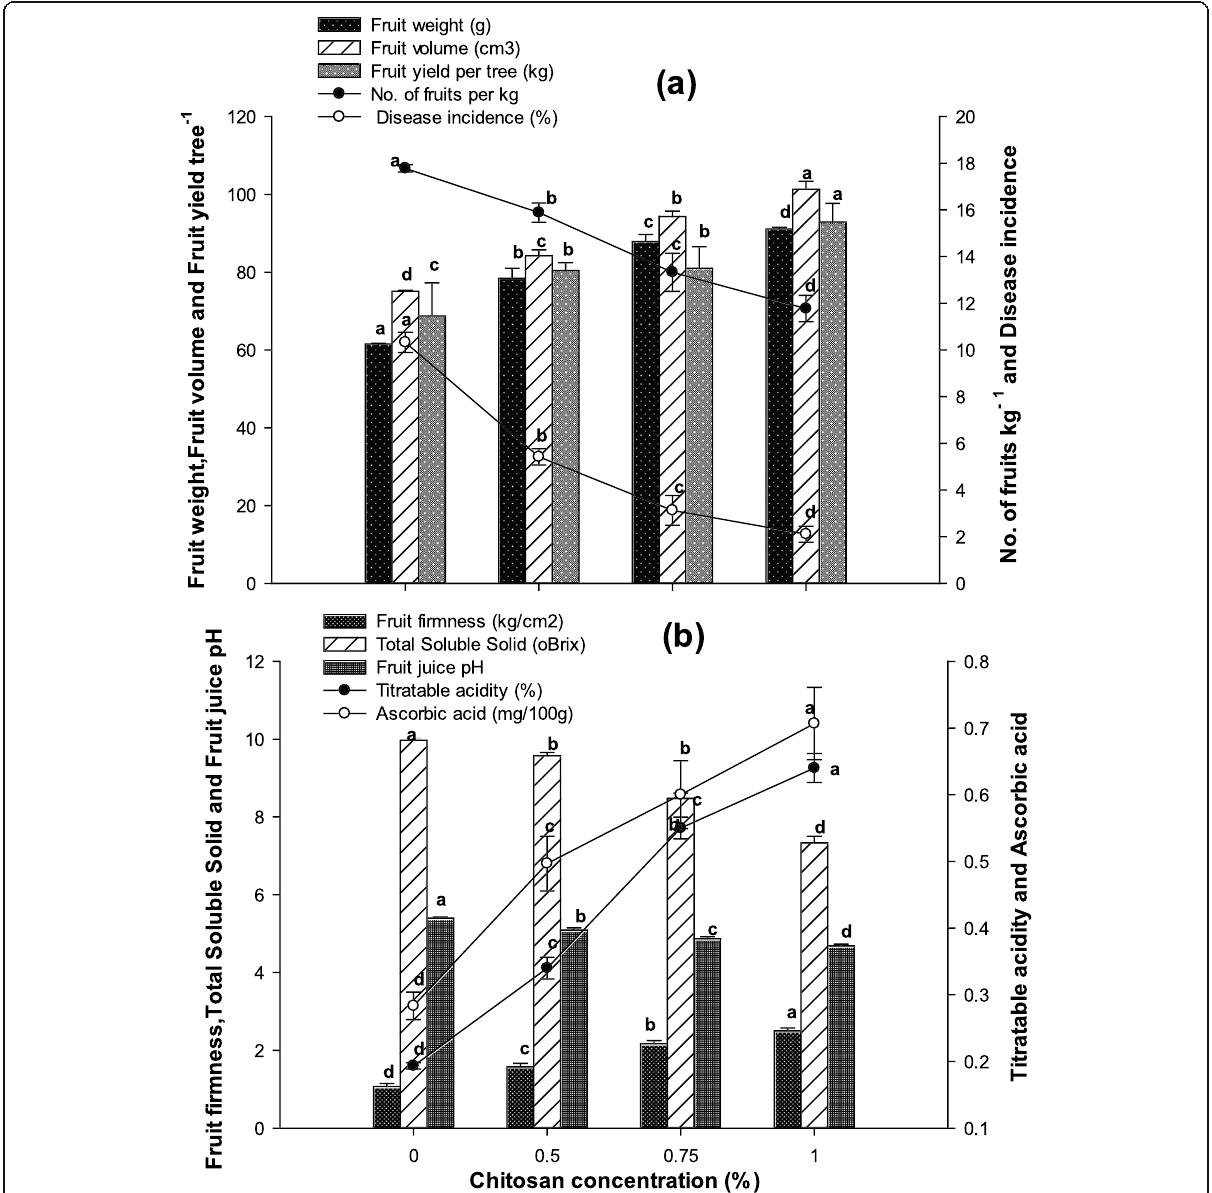
Fig. 3 Various attributes of peach as influenced by different chitosan concentrations. The vertical bars represent standard error. Different letters next to the mean values in each bar indicate a significant difference (LSD p ≤